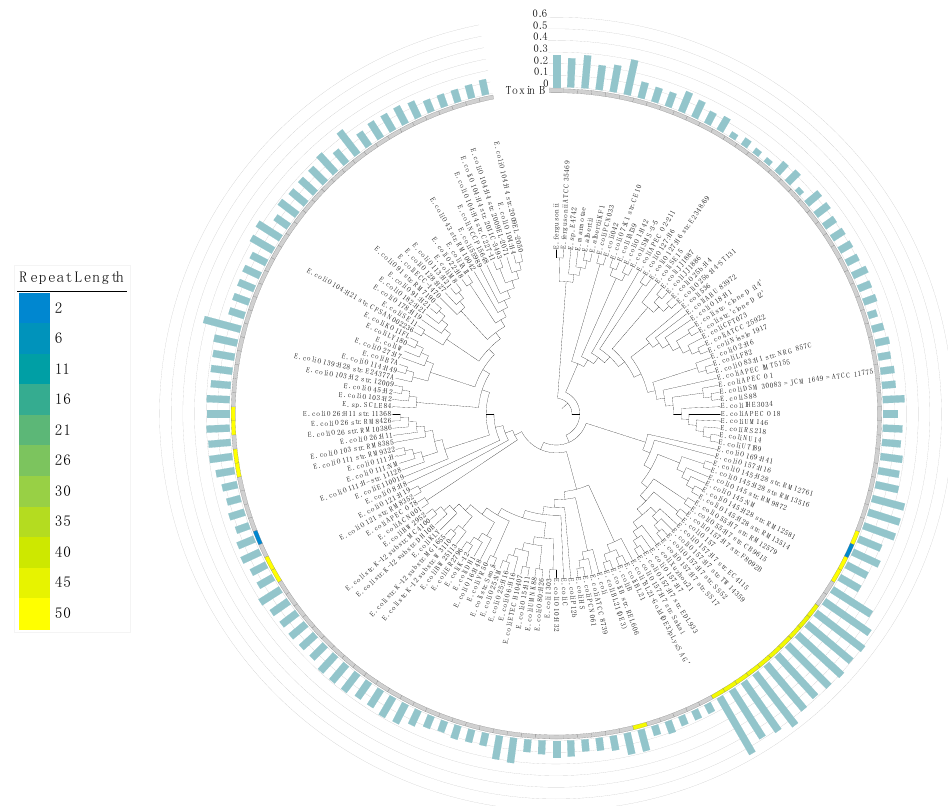
Figure 3. Maximum likelihood phylogenetic tree of the genus Escherichia . The phylogenetic tree was constructed based on the core genes in all 140 strains of the genus Escherichia ; the NCBI Taxonomy ID was replaced by the name of each strain. The distribution of the number of HPT repeats in the toxin B gene is shown in a heatmap. Blue and yellow colors denote the smallest and largest number of repeats, respectively. The gray color indicates the loss of toxin B. The bar plot in light green shows the frequency of occurrence of transcriptional regulatory genes in intergenic HPTs (%). The axis of the bar plot is 0 to 0.6% with 0.1% intervals.